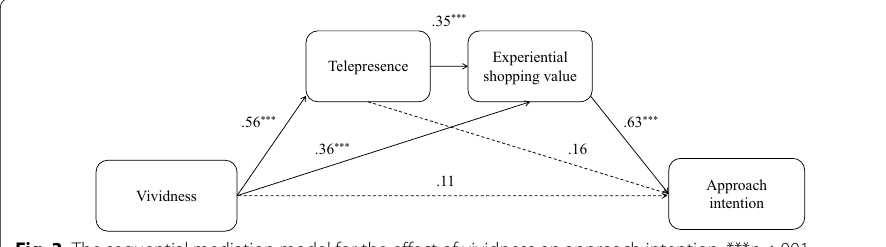
Fig. 3 The sequential mediation model for the effect of vividness on approach intention. *** p <